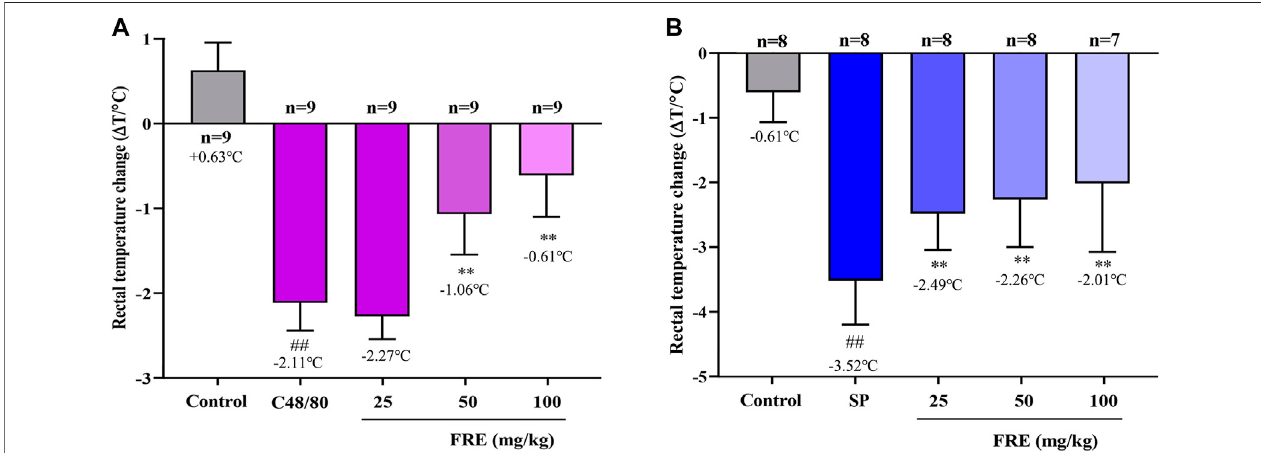
FIGURE 4 | FRE suppresses the Mrgpr- and IgE/Fc ε RI-mediated MC degranulation in vivo. (A) Effect of FRE on the rectal temperature of C48/80-treated mice. Mice were i.p. injectedC48/80(4 mg/kg)5 minbeforeFREadministration( i.p. ).ThirtyminutesafterC48/80treatment,therectaltemperaturewasmeasured. ## p < 0.01 vs. control and ** p < 0.01 vs. C48/80 alone group. (B) Effect of FRE on the rectal temperature of PSA mice. The sensitized mice were pretreated with FRE ( i.p. ) for 30 min and then i.v. challenged with SP (200 μ g/mouse). The rectal temperature was monitored 20 min later. ## p < 0.01 vs. control and ** p < 0.01 vs. SP alone group.